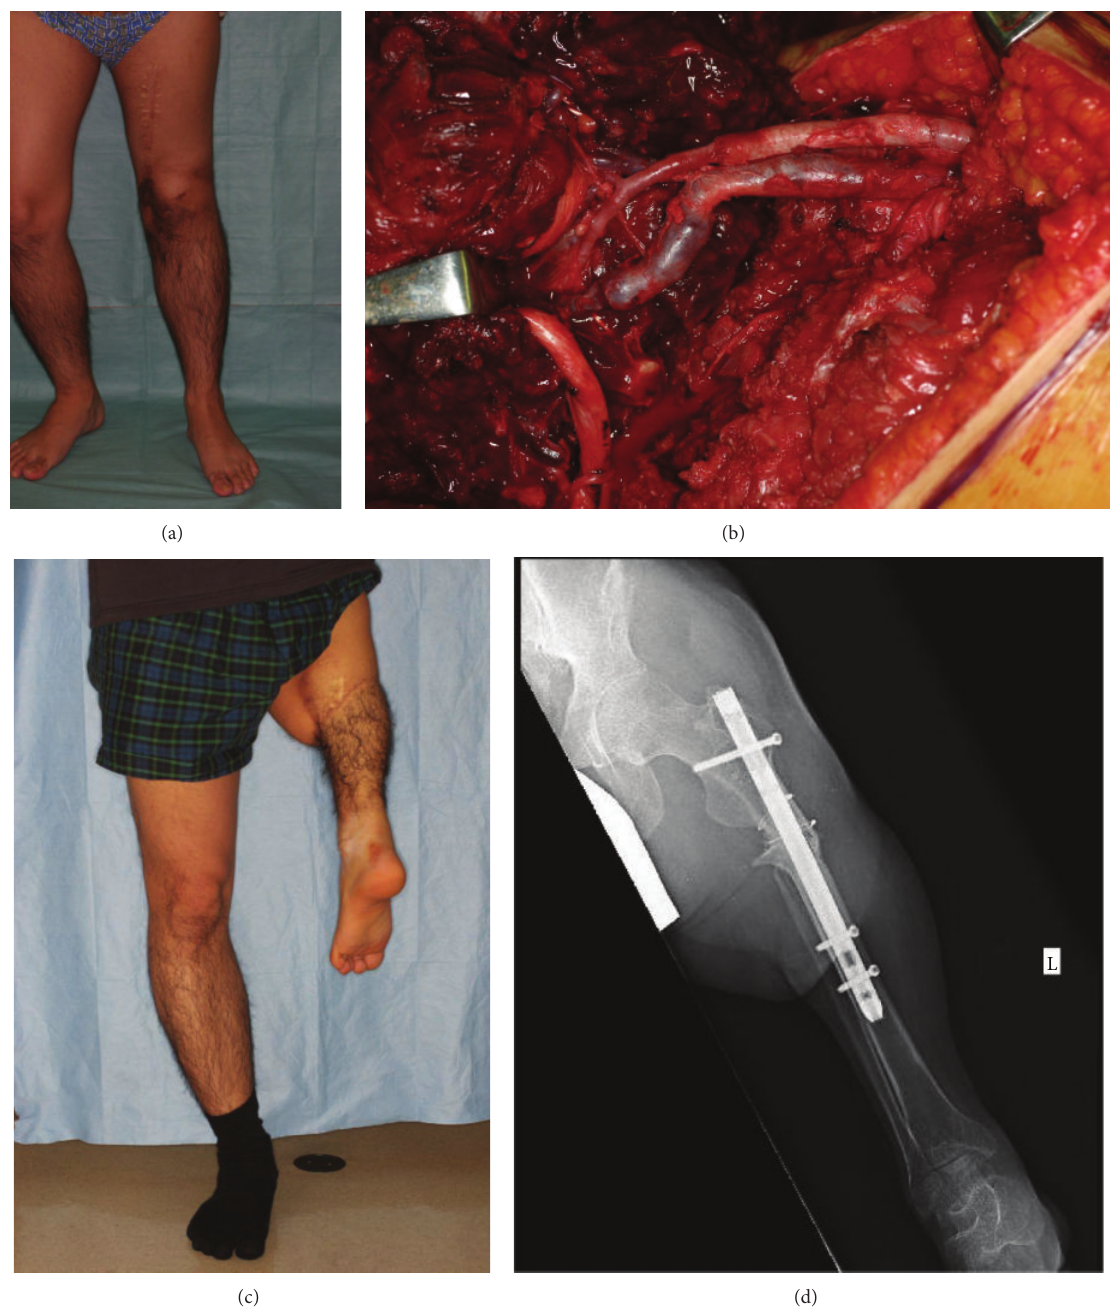
Figure 2: (a) Preoperative status with decreased range of motion due to infection of the prosthetic knee joint, (b) vascular reconstruction after rotation of the distal leg, (c) appearance 3-year after rotationplasty, (d) X-ray finding 3-year after